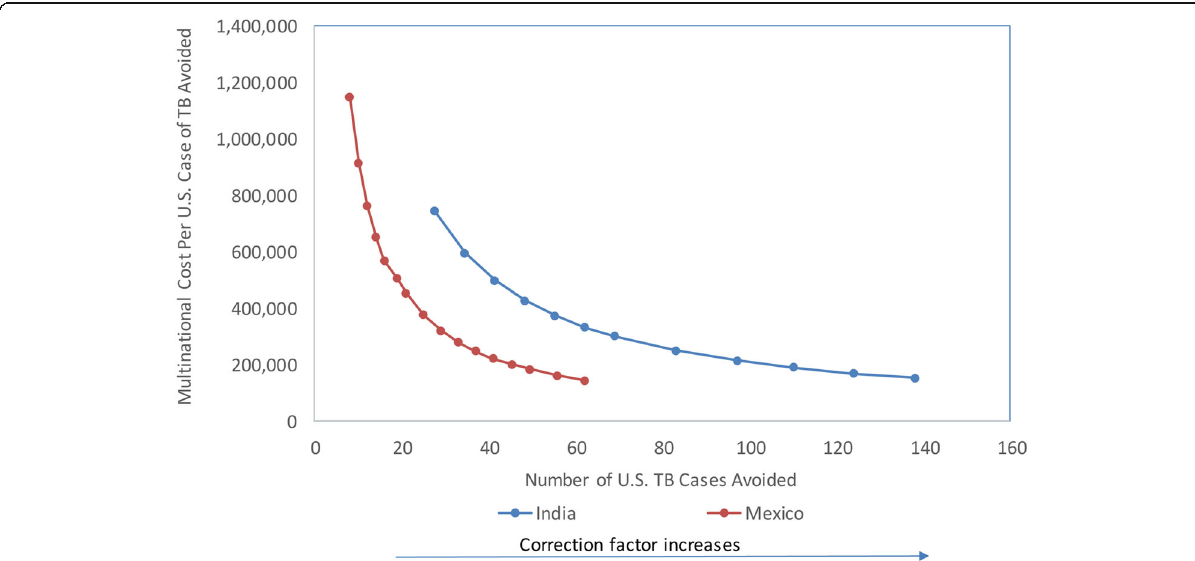
Fig. 2 Cost per U.S. Case of Tuberculosis Avoided Under a Screening Program for Indian H-1B and H-4 Nonimmigrant Visa Applicants. Notes: Graph presents the cost per U.S. case of tuberculosis (TB) avoided as the number of U.S. TB cases avoided and correction factor increases. The correction factor was varied between 10 and 100% to account for the potential differences between immigrants and NIVs. In the model, the screening outcomes for immigrants are applied to the NIV population; however, it is possible that the TB prevalence would be lower in the NIV population. The correction factor was applied to the percent of the applicants with evidence of TB (resulting in Class B1 NIV arrivals recommended for U.S. follow-up and